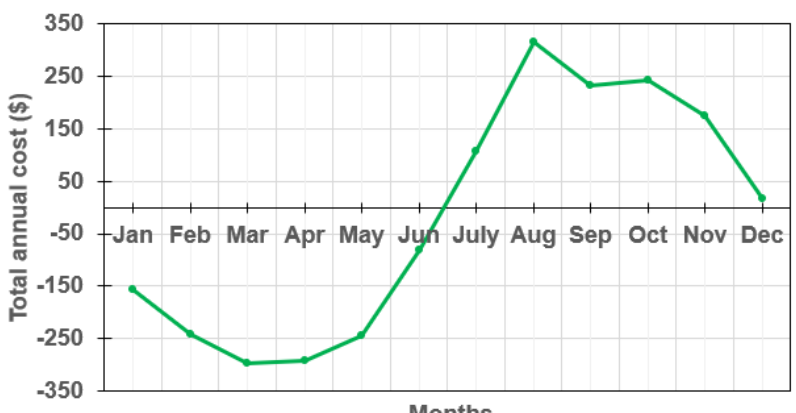
Figure 10. Variation of the total annual cost with k = 0.95, M(net).